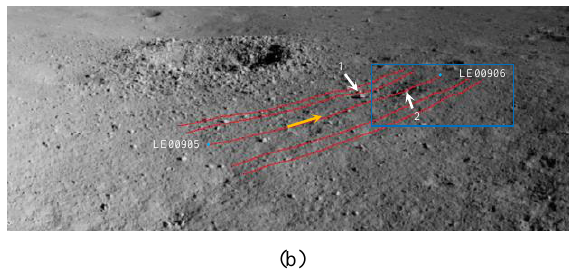
Figure 10. Searched path projections on Navcam image mosaic at waypoint LE00905 (a) and LE00802 (b).